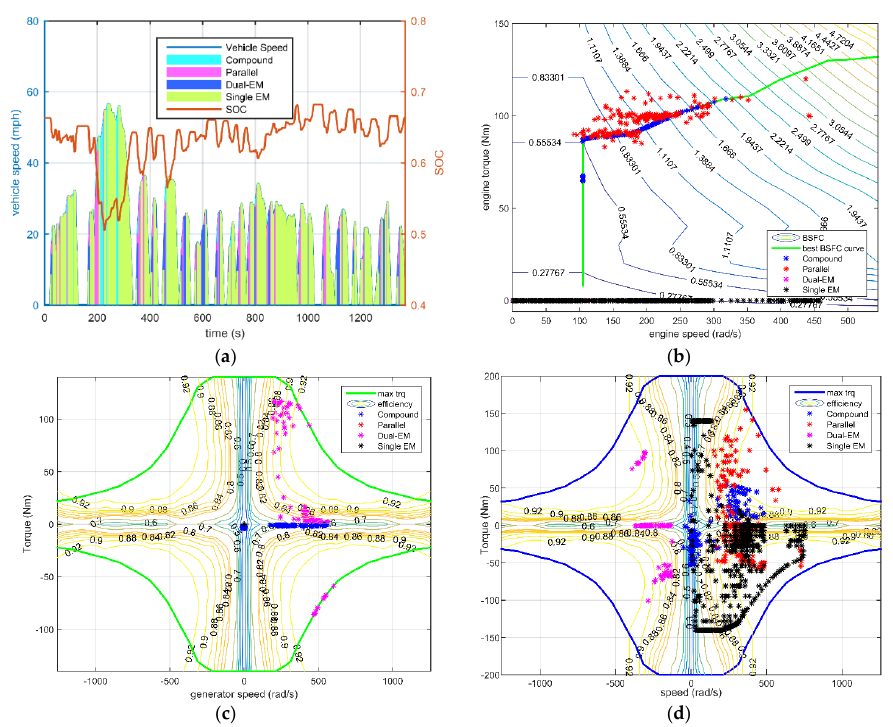
Figure 11. ( a ) Battery SoC trajectory and mode selection over the UDDS drive cycle; ( b ) rngine optimal operation points over the UDDS drive cycle; ( c ) EMA operating points over the UDDS drive cycle; ( d ) EMB operating points over the UDDS drive cycle.